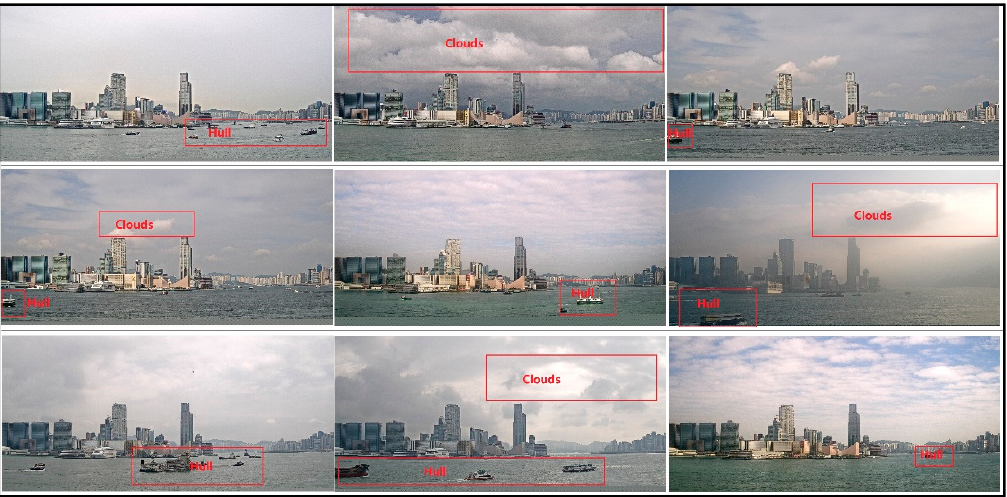
Figure 3. Some image samples in the database.